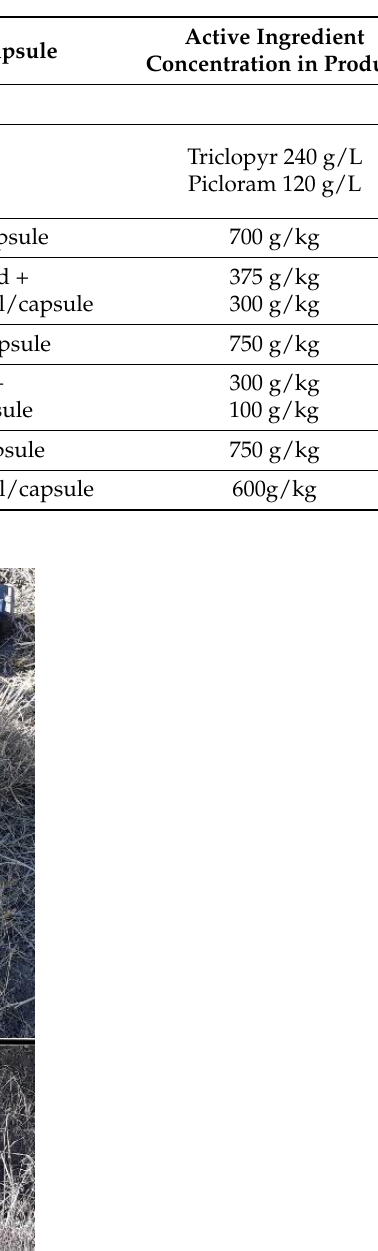
Table 1. Chemical herbicide treatments for the intact plant trials.